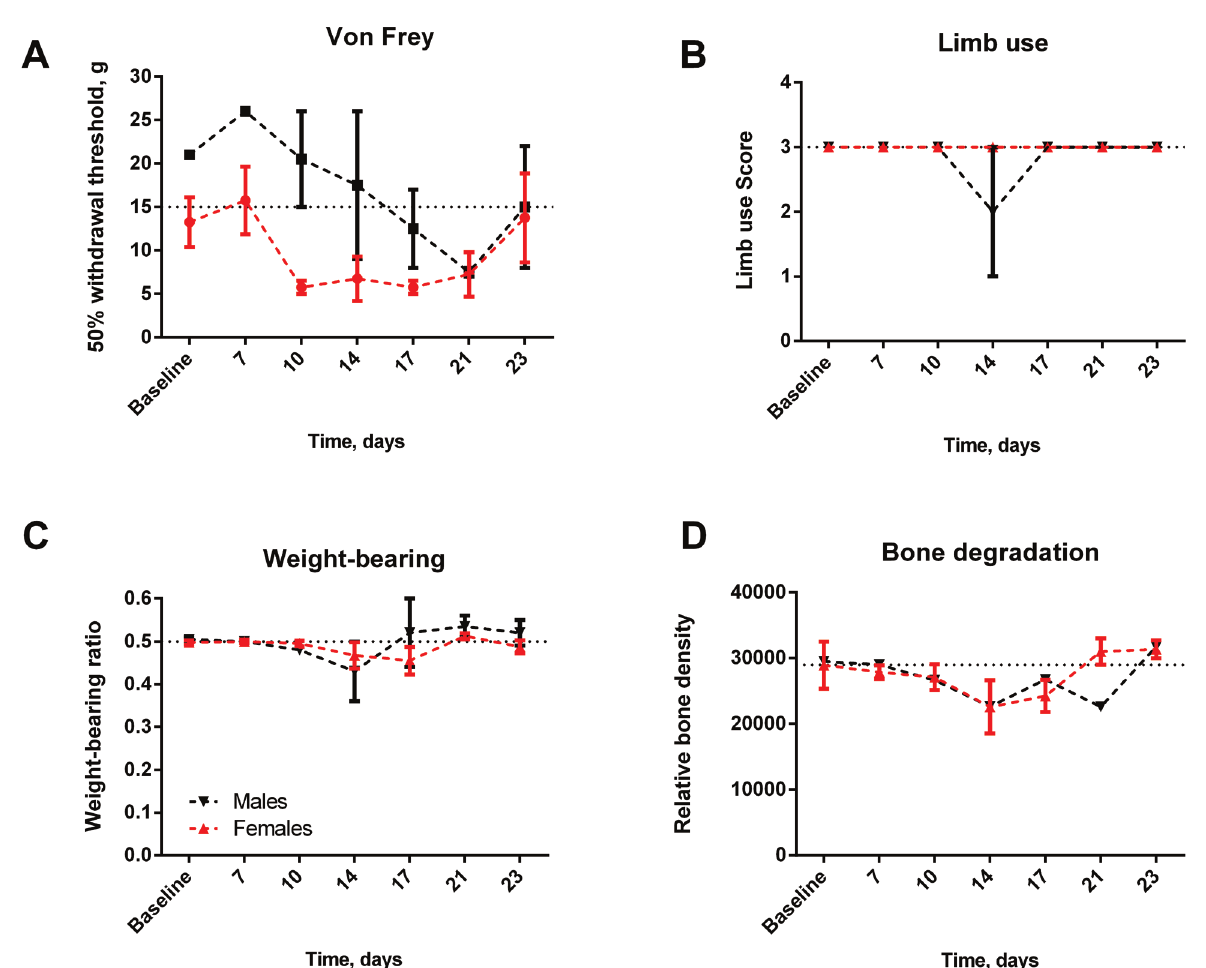
Figure 5. Pain-related behavior and relative bone density in animal losing bioluminescence signal during the experiment. ( A ) A transient, yet insignificant, decrease was observed in the 50% threshold in females. ( B , C ) Limb use and weight-bearing deficit was not observed in either females or males during the experiment. ( D ) The relative bone density remained the same throughout the experiment in both males and